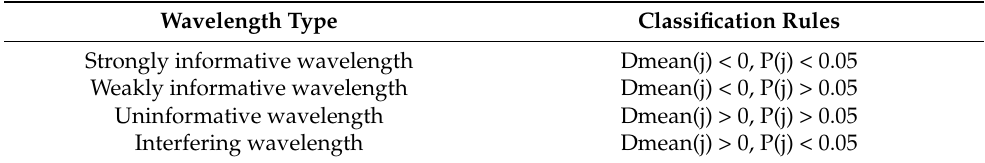
Table 1. Variable classification rules.